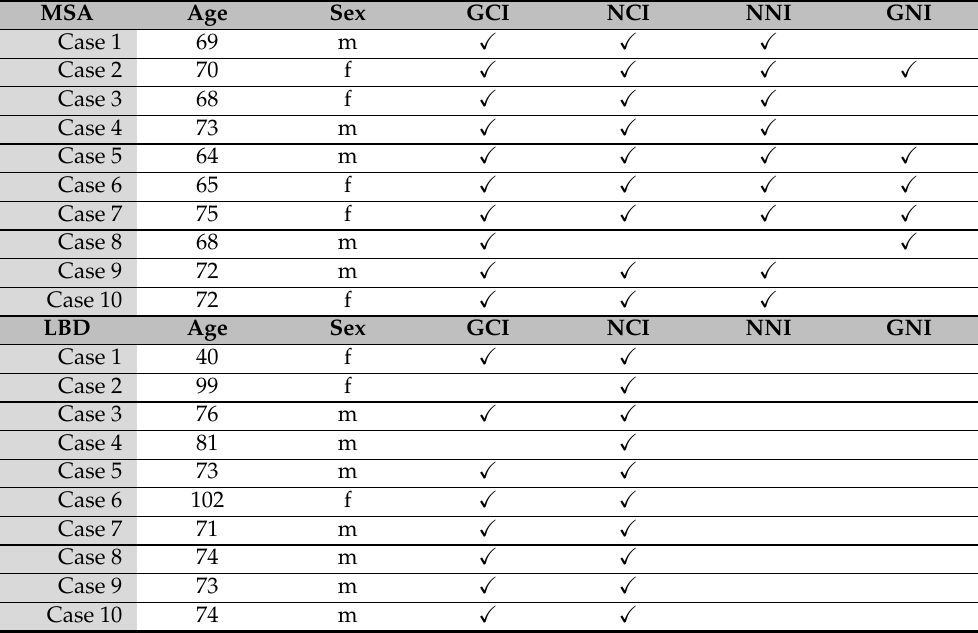
Table 1. Analysis of human MSA and LBD brain tissue for different types of inclusions. A series of 10 MSA and 10 LBD cases were examined the presence ( (cid:88) ) or absence of alpha-synuclein aggregates in different subcellular locations and cell types. Abbreviations: glial cytoplasmic inclusion (GCI), glial nuclear inclusion (GNI), Lewy body dementia (LBD), multiple system atrophy (MSA), neuronal cytoplasmic inclusion (NCI), neuronal nuclear inclusion